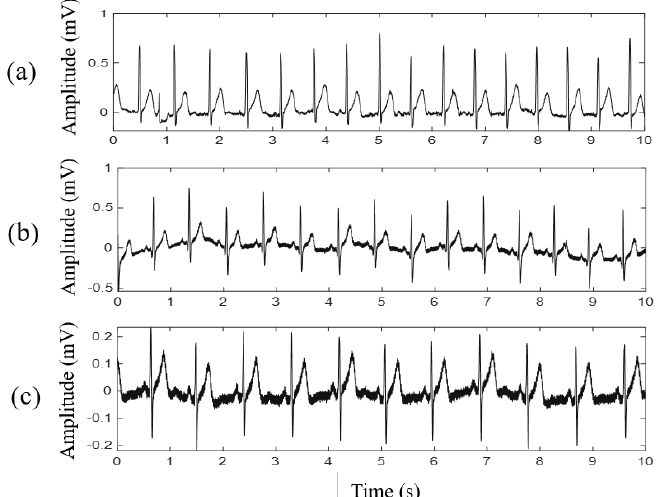
Figure 9. ECG signals acquired by different clothing designs, including smart clothes based on ( a ) parameterized 3D human body model and ( b ) average 3D human body model, as well as ( c ) commercial gym clothes with chest strap.